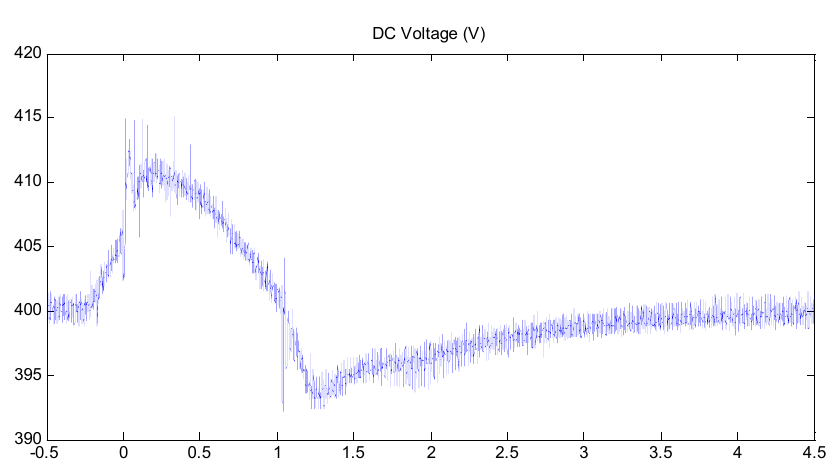
Figure 17. DC voltage, (V) vs. time, (s).